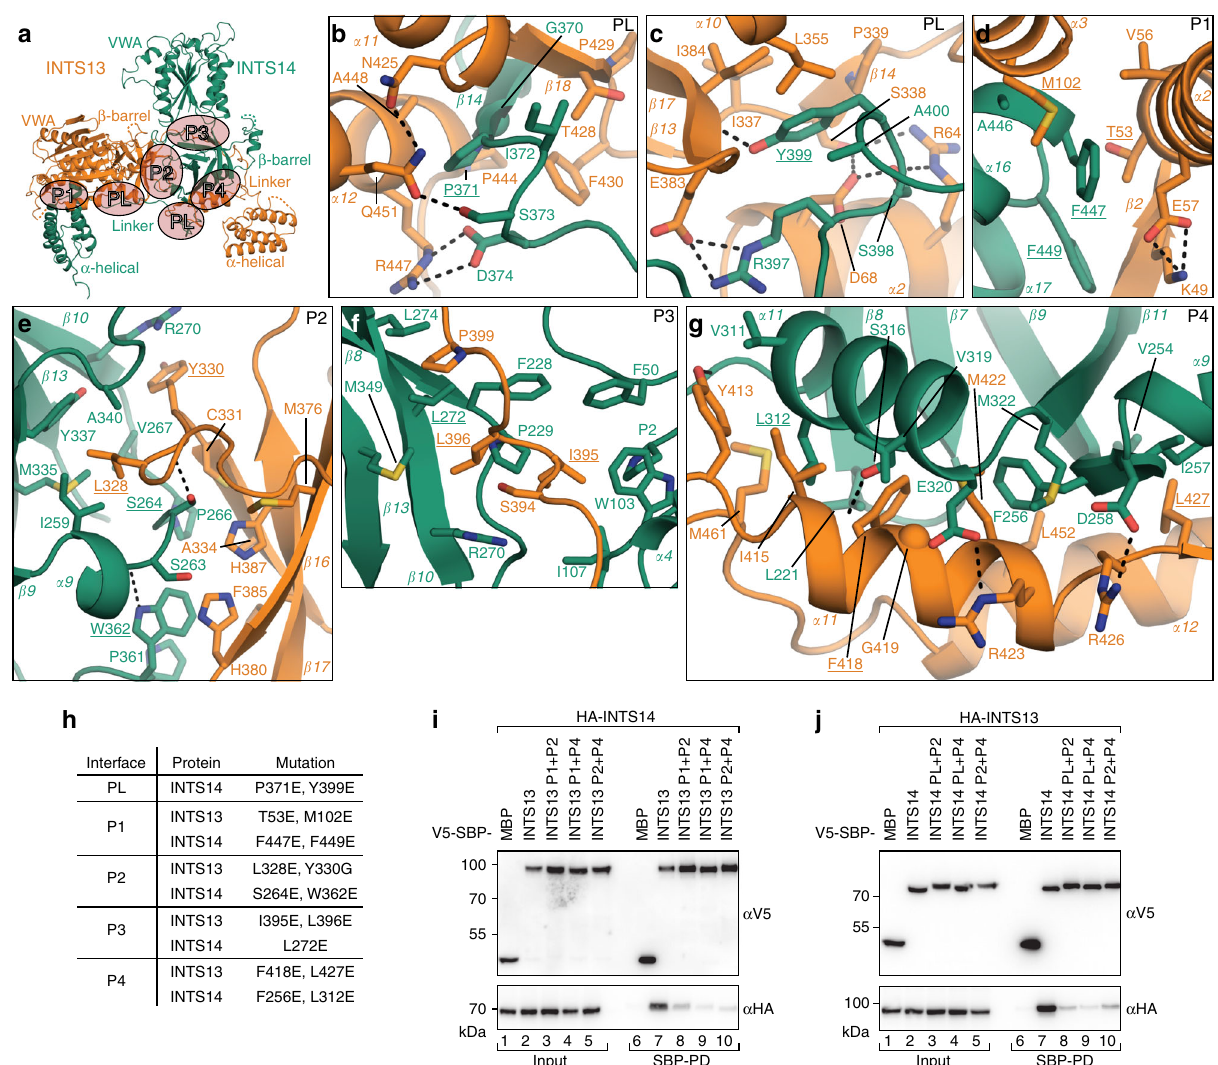
Fig. 2 The extensive interface between INTS13 and INTS14 requires several mutations for disruption. a Overview of the complex between INTS13 (orange) and INTS14 (green) with interface patches PL and P1-4 highlighted by orange ovals and labeled accordingly. b – g Close-up views of the interface patches PL and P1 – 4 as indicated in a . Secondary structure elements as well as side-chains of interface residues are shown and labeled. Dotted lines indicate hydrogen bonds. Residues mutated in this study are underlined. h List of point mutations in interface patches that were tested for effects on complex formation. i , j Coprecipitation experiments from HEK293T cells expressing patch double mutants in V5-SBP-INTS13 i or INTS14 j with the corresponding λ N-HA-tagged binding partner. V5-SBP-MBP and the wt proteins were used as negative and positive controls, respectively. Inputs ( α V5-blots 1%, α HA-blots 0.5%) and bound fractions ( α V5-blots 4%, α HA-blots 20% and 10%) were analyzed by Western